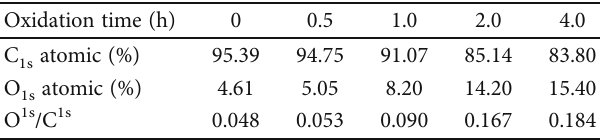
Figure 2: The X-ray photoelectron spectrum of unoxidized and oxidized UHMWPE. Table 1: The content ratio of O 1s /C 1s of unoxidized and oxidized UHMWPE.